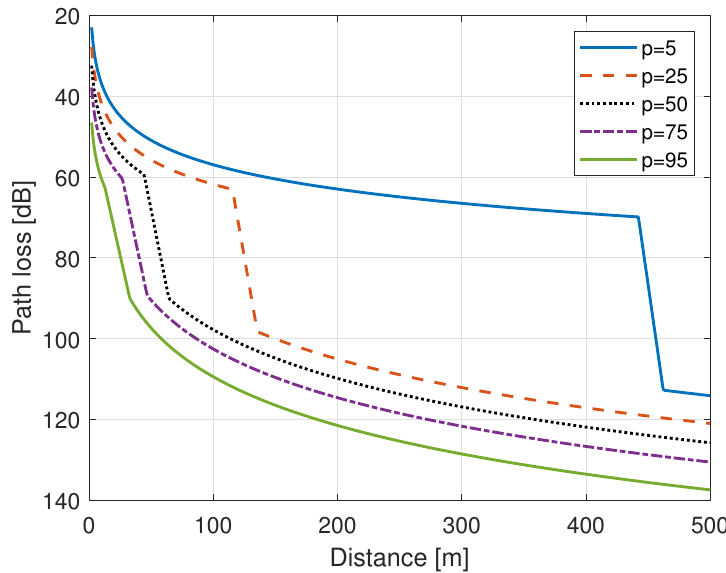
Figure 2. Path loss for outdoor device-to-device (D2D) communication with different location percentage. Algorithm 2 ITU outdoor D2D propagation